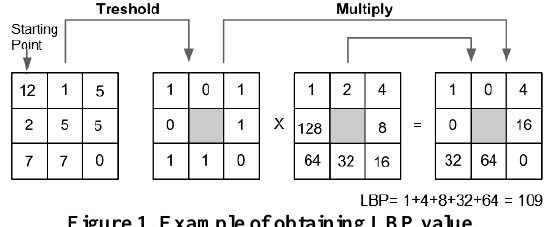
Figure 1. Example of obtaining LBP value.